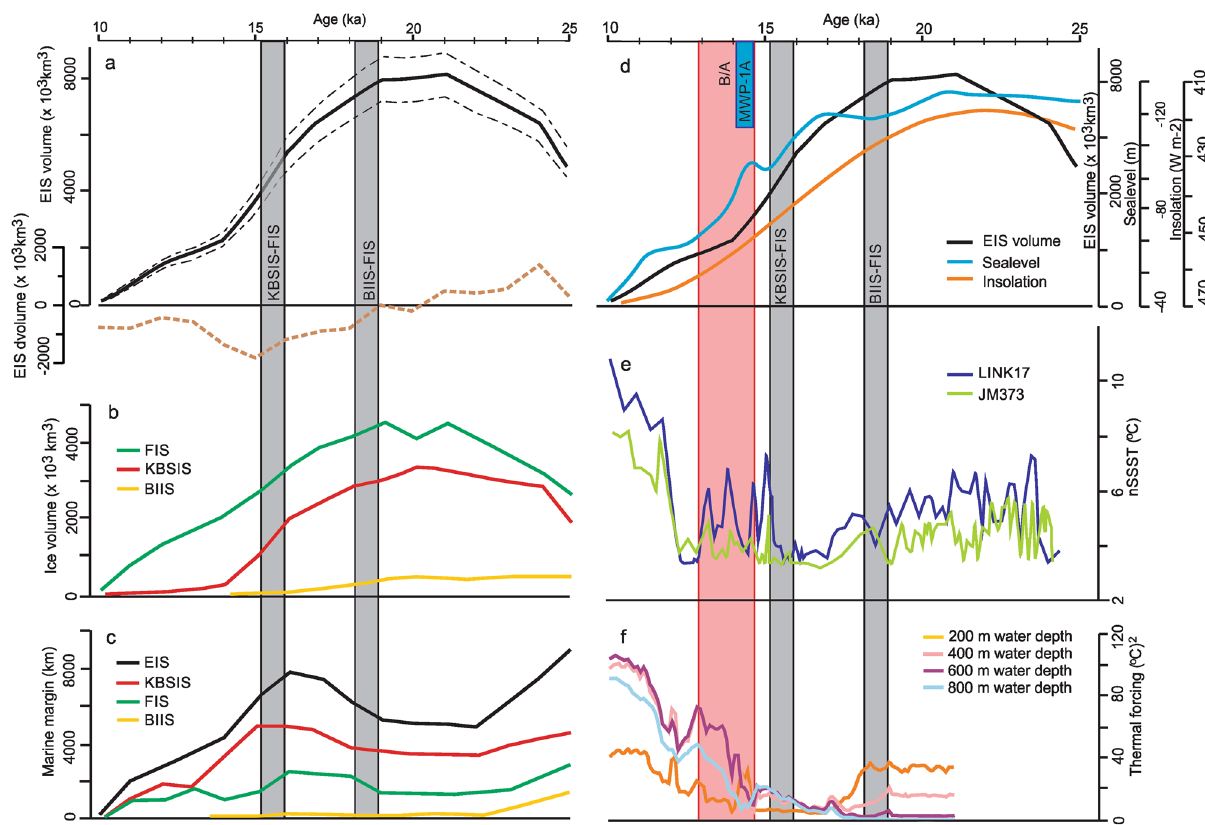
Fig. 4 Time series of Eurasian Ice Sheet development and possible controlling factors for the period 25 to 10 ka. a Ice volume of the EIS (black line), model run with shear stress values by ±20% (broken black lines) and volume change in thousand km 3 (broken brown line). b Ice volume of the FIS (green line), KBSIS (red line), and BIIS (yellow line) in km 3 . c Length of marine margin in km (colour coding as in a , b ). d Summer insolation at 65°N in Wm-2 84 (orange line), EIS volume in thousand km 3 (black line) and global sea level 85 (blue line). e Summer sea surface temperature estimates based on planktonic foraminifera assemblages from two deep sea cores, Link 17 and JM373. f Modelling of eastern Nordic Seas ocean temperatures 36 . Grey columns indicate the millennium for break-up of the Eurasian Ice Sheet (EIS) into the Kara-Barents Sea Ice Sheet (KBSIS), Fennoscandian Ice Sheet (FIS) and British-Irish Ice Sheet (BIIS). Red column indicate the Bølling-Allerød (B/A) time period and Meltwater Pulse-1A (MWP-1A) are indicated with a blue